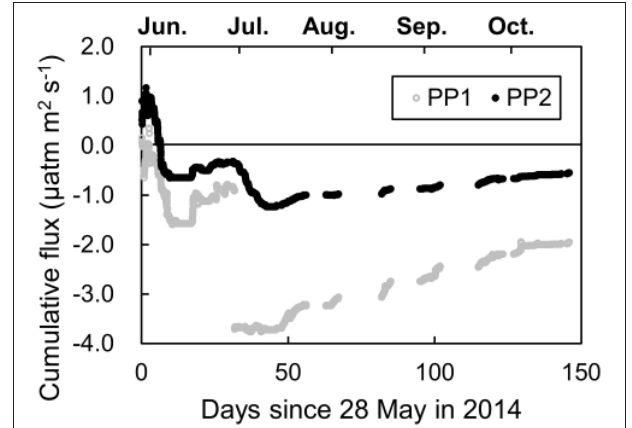
FIGURE 6 | Cumulative EC flux after PP1 and PP2. The data during the gap period due to bad weather conditions were not counted. The seasonal trends of the fluxes were roughly the same, except for the large change around 30 days after the measurements started. This comparison shows that the PP2 did not bias the seasonal trend and improved the continuity.